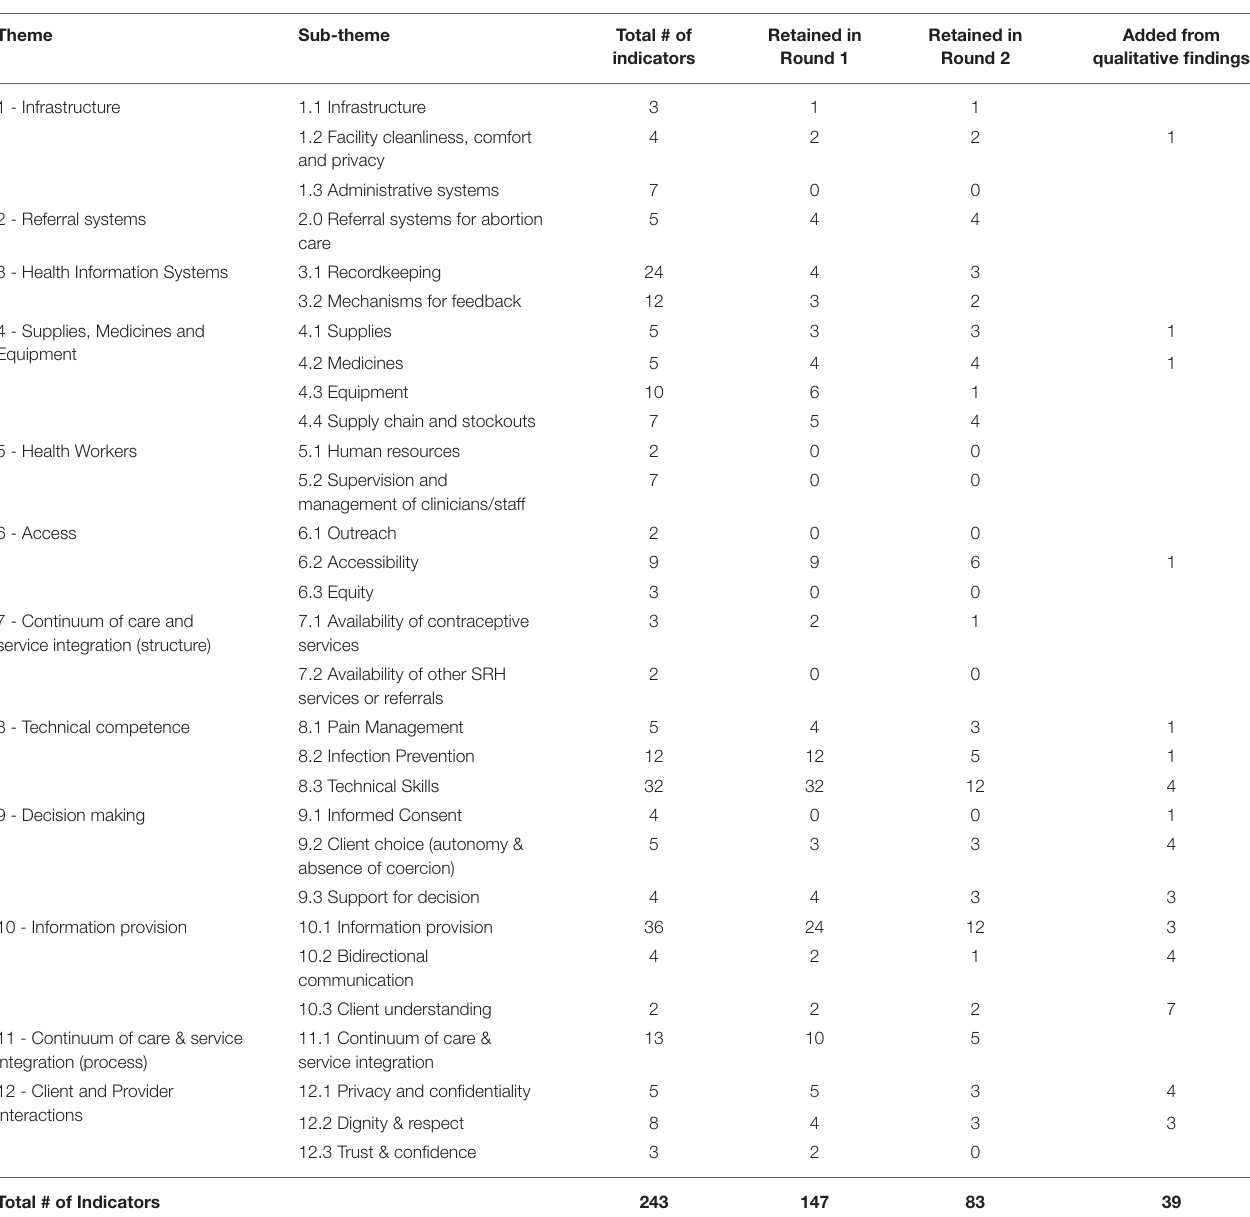
TABLE 1 | Stakeholder driven study indicator selection. Theme Sub-theme Total # of